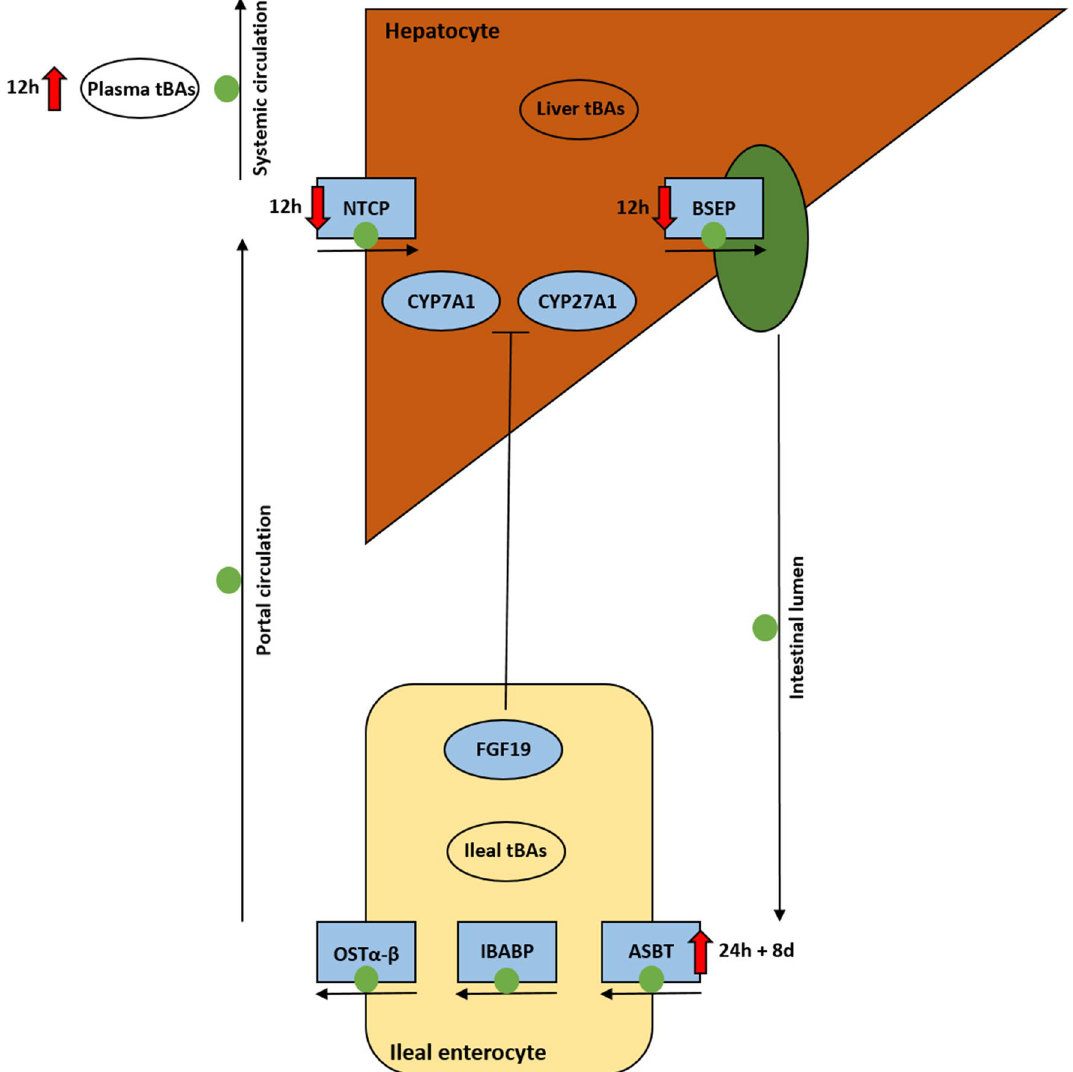
Figure 7. An overview of the enterohepatic circulation (EHC) of bile acids (BAs) and changes herein related to FIRS and liver inflammation. CYP7A1 and CYP27A1 play a role in BAs production, which can be inhibited by FGF19 . Physiologically, BAs are transported from hepatocytes via BSEP , via the gallbladder subsequently into the intestinal lumen. Most BAs are reabsorbed in the terminal ileum by ASBT . Following enterocyte uptake, BAs bind to IBABP to traverse the cytoplasm of epithelial cells. BAs exit the basolateral site of the enterocyte via OSTα - OSTβ . Via the portal vein, BAs are transported back to the liver. NTCP takes up the BAs into the hepatocyte to be recycled. Decreased expression of NTCP and BSEP and resultant increased plasma BA levels are associated with FIRS and liver inflammation. Increased ASBT expression may also be inflammation dependent, or a compensatory mechanism to the postulated lower intraluminal BAs supply to maintain a constant BA pool in the NTCP expression might thus be a compensatory mechanism to protect the liver against damage during sepsis as BAs have been shown to be hepatotoxic during cholestasis 11 . Our results probably show an earlier disease state in which LPS induced sepsis not yet has progressed to cholestasis since hepatic BA levels were unchanged, indicating that these animals were not cholestatic. Another compensatory mechanism might be the unchanged BAs synthesis, which in the normal situation would be expected to increase to remain a constant BA pool. Intestinal ASBT mRNA expression was increased in animals 24 hours after IA LPS administration, which might be a response to the decreased transport of BAs from the liver to the gut 12 hours after IA LPS administra- tion. No changes in BAs concentrations in the ileum were observed at any of the time points, suggesting that the increased ASBT expression may be a compensatory mechanism to the postulated lower intraluminal BAs supply to keep a constant BA pool in the EHC, as ASBT is known to play a major role in BA homeostasis 34 . Moreover, it might also be related to the increased cytokines such as ileal TNF-α and IL-18 levels, which in previous studies